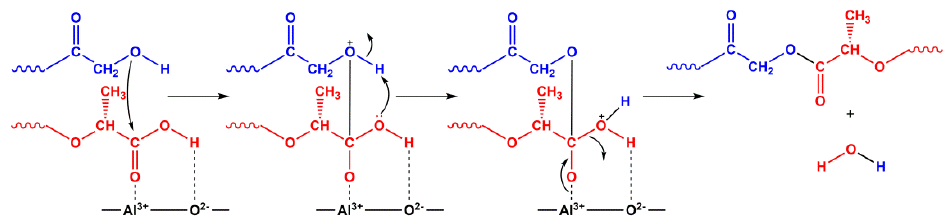
Figure 4. Polycondensation of GAO and LAO on the LAS of γ -Al 2 O 3 .